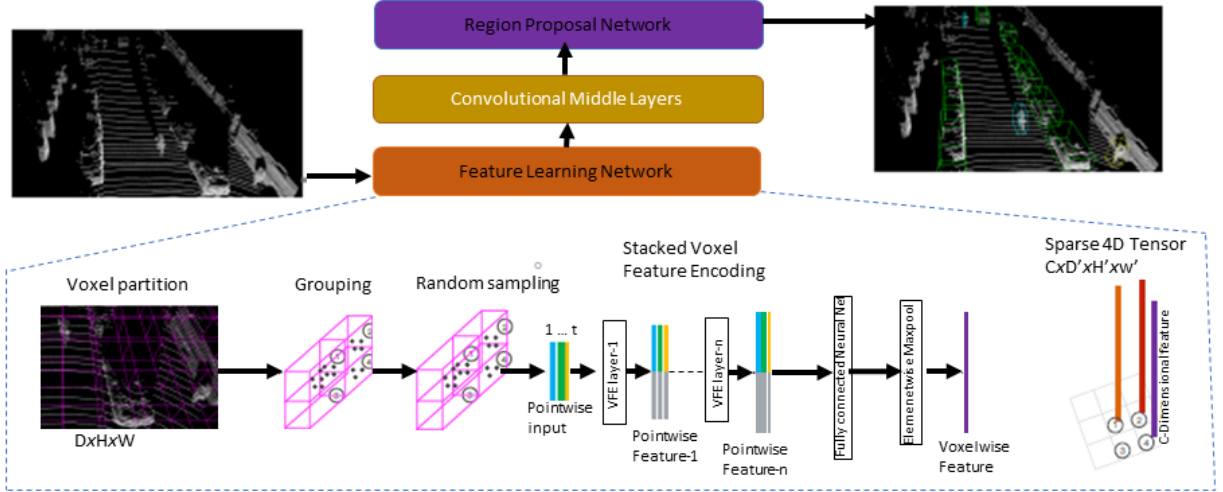
Figure 5. VoxelNet Architecture [9]. The raw point cloud is partitioned into voxels and transformed into vector representation by the feature learning network. The convolutional middle layers process the 4D tensor vector before the region proposal network generates 3D